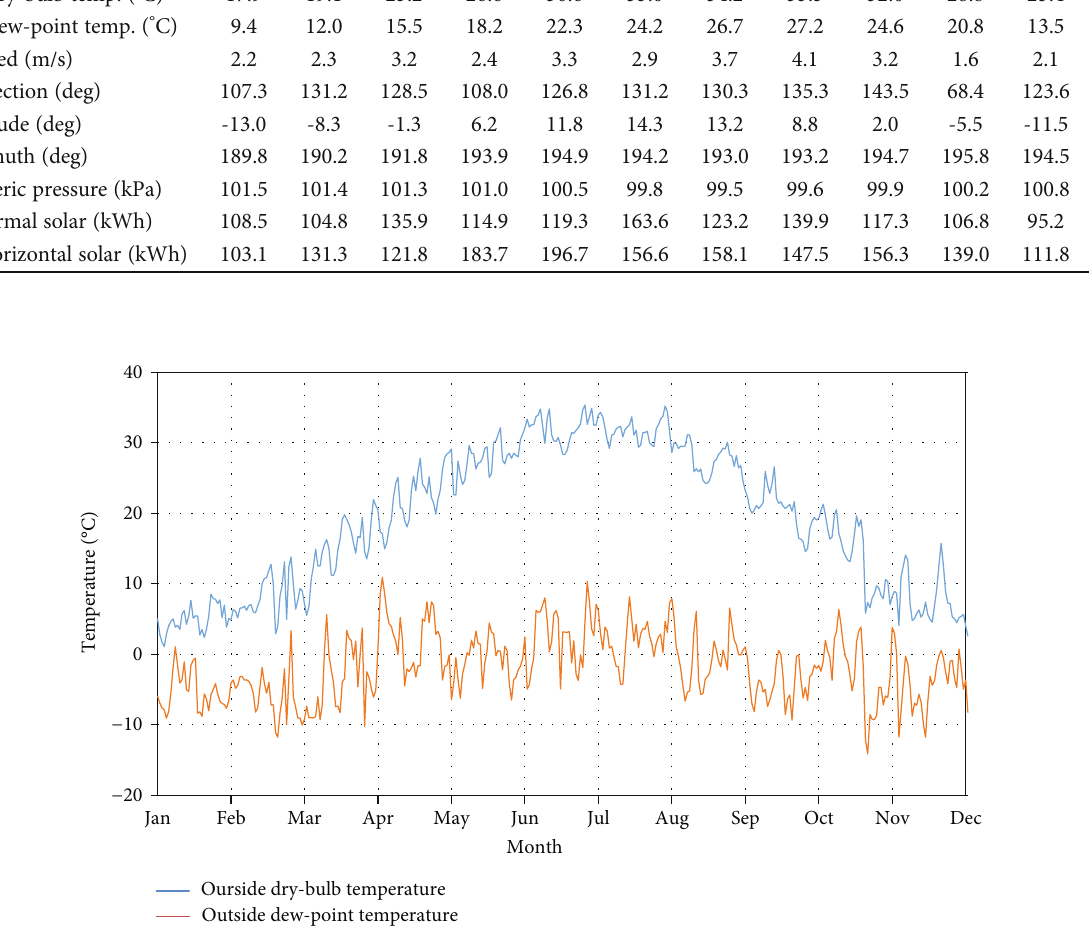
Figure 4: Monthly dry-bulb and dew-point temperature outside the